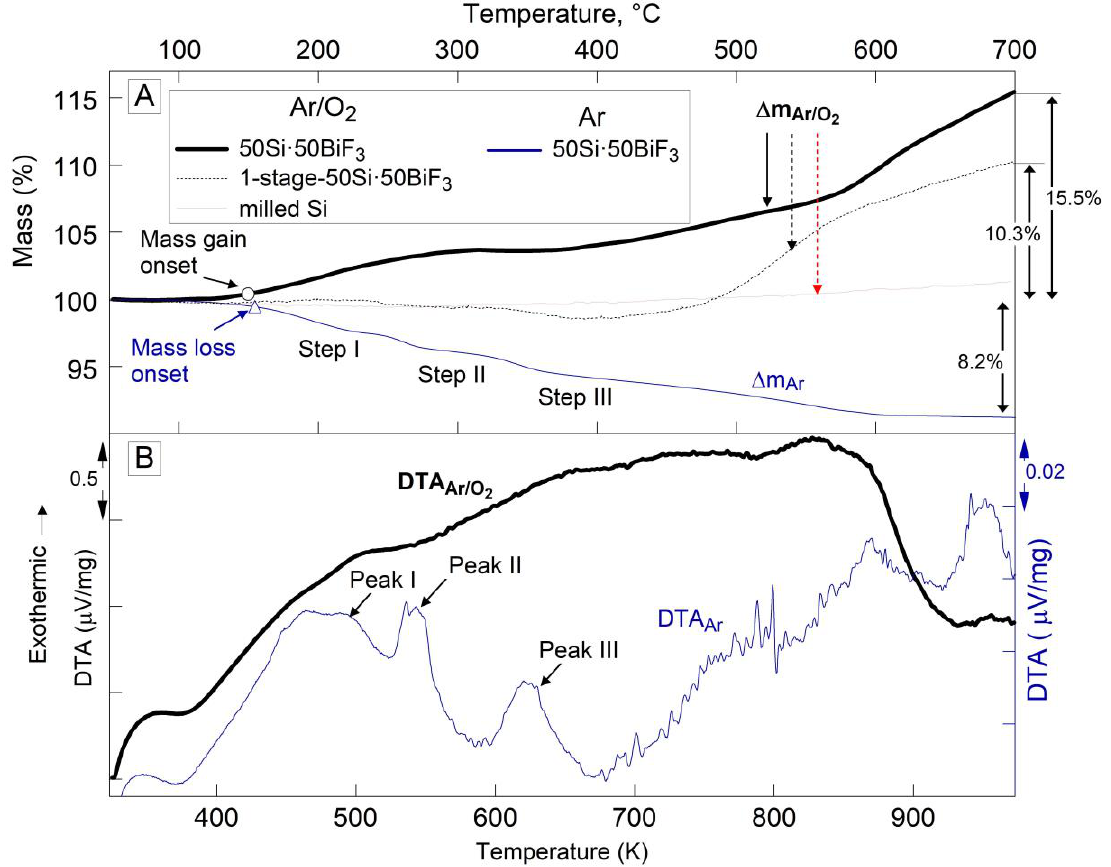
Figure 5. ( A ) TG and corresponding ( B ) DTA traces for 50Si·50BiF 3 in heated at 5 K/min in oxidizing